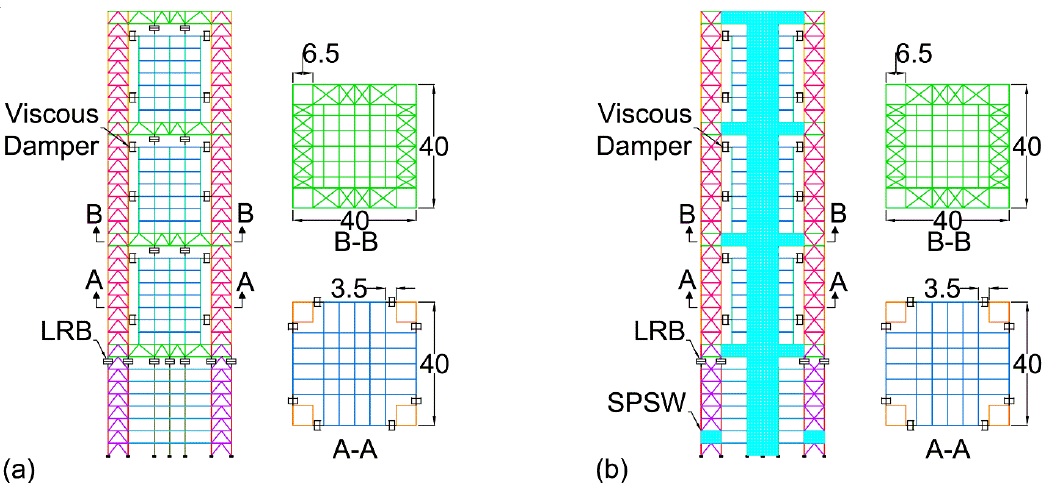
Figure 2. Configurations: ( a ) MSCSS with mid-story isolation [21] and ( b ) newly proposed MSCSS. Dimensions are in meters . (Adapted with permission from [21])